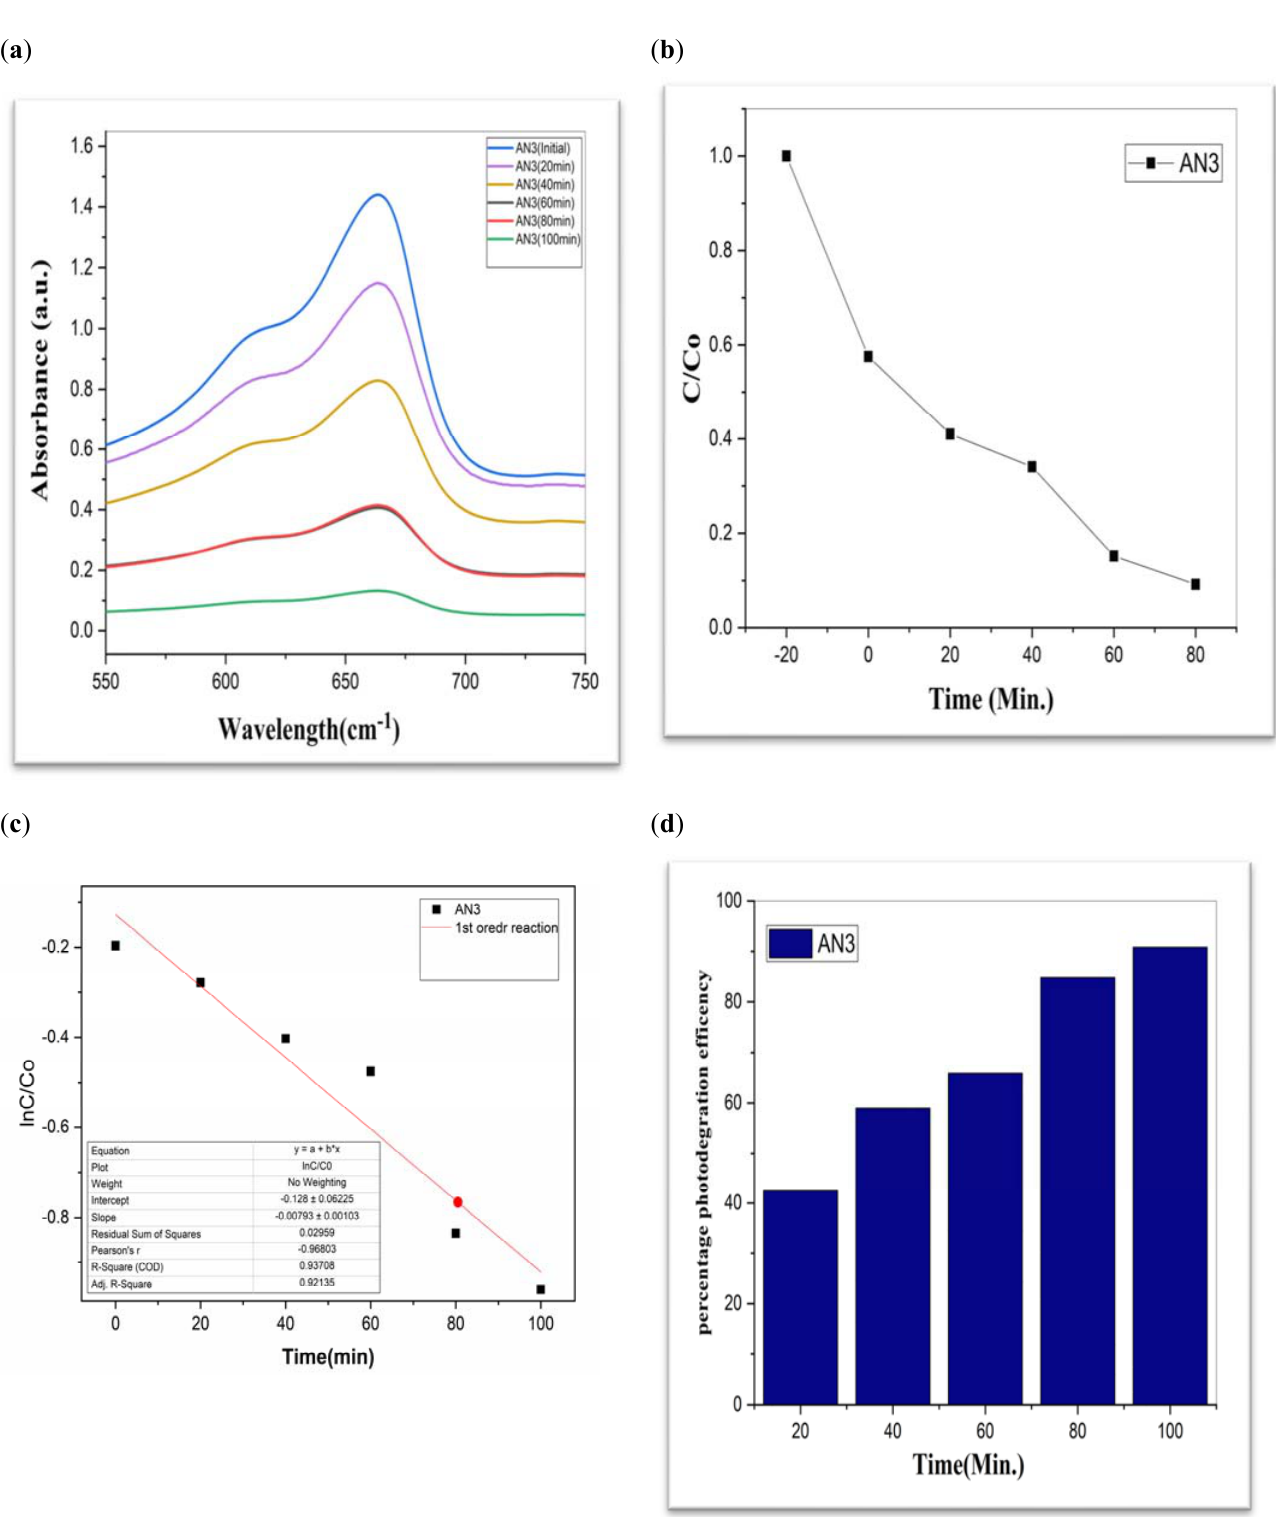
Figure 7. AN3 ( a ) graphical representation of degradation of methylene blue; ( b ) C/C 0 ; ( c ) lnC/C 0 ; ( d ) %age e ffi ciency.